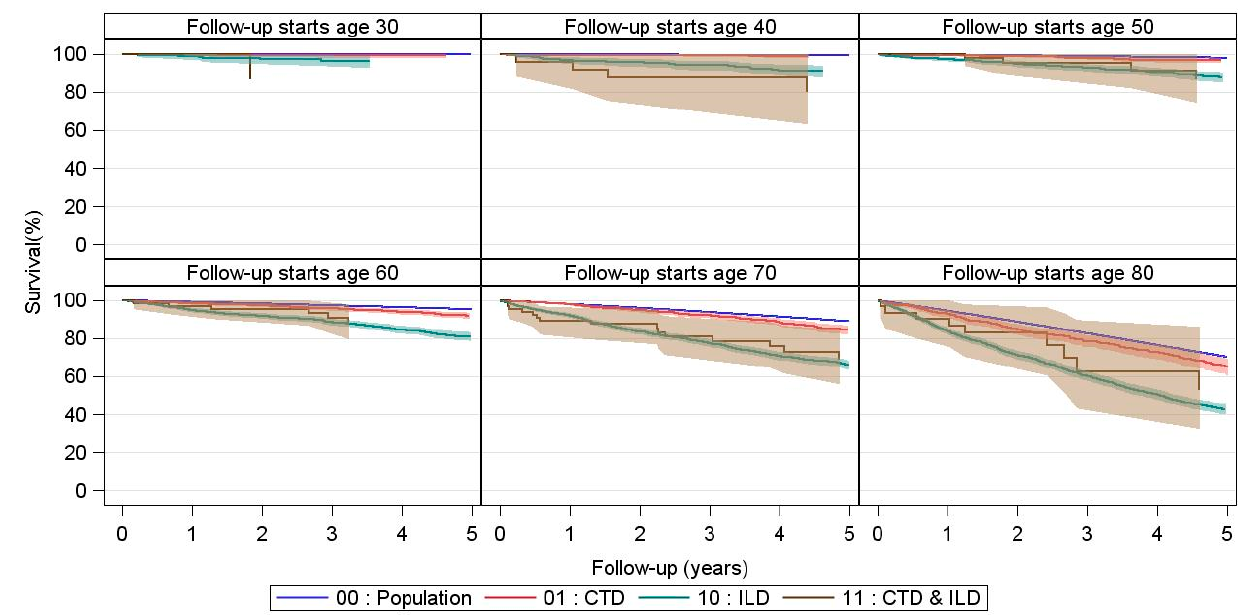
Figure 2. Survival curves for CTD patients with and without ILD stratified by age compared with non-CTD ILD patients and the general population in the same age stratum.